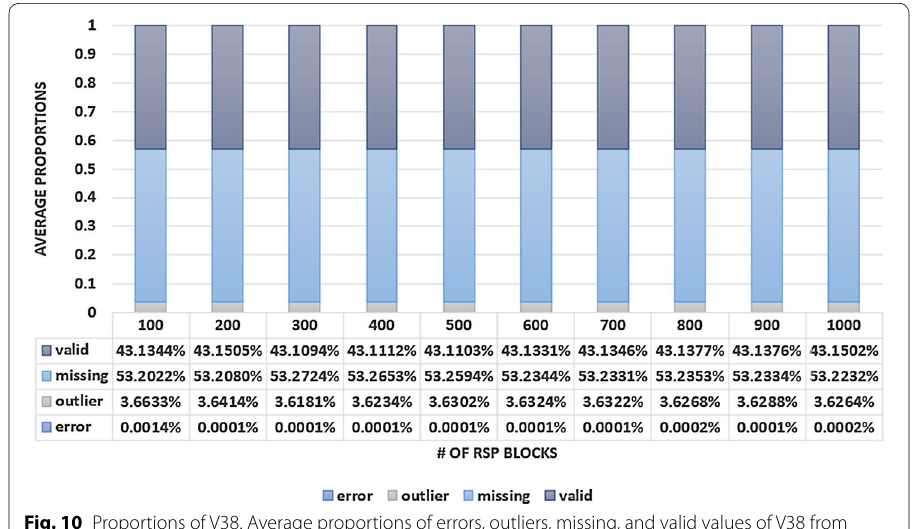
Fig. 10 Proportions of V38. Average proportions of errors, outliers, missing, and valid values of V38 from incremental batches of RSP blocks (from 100 to 1000)